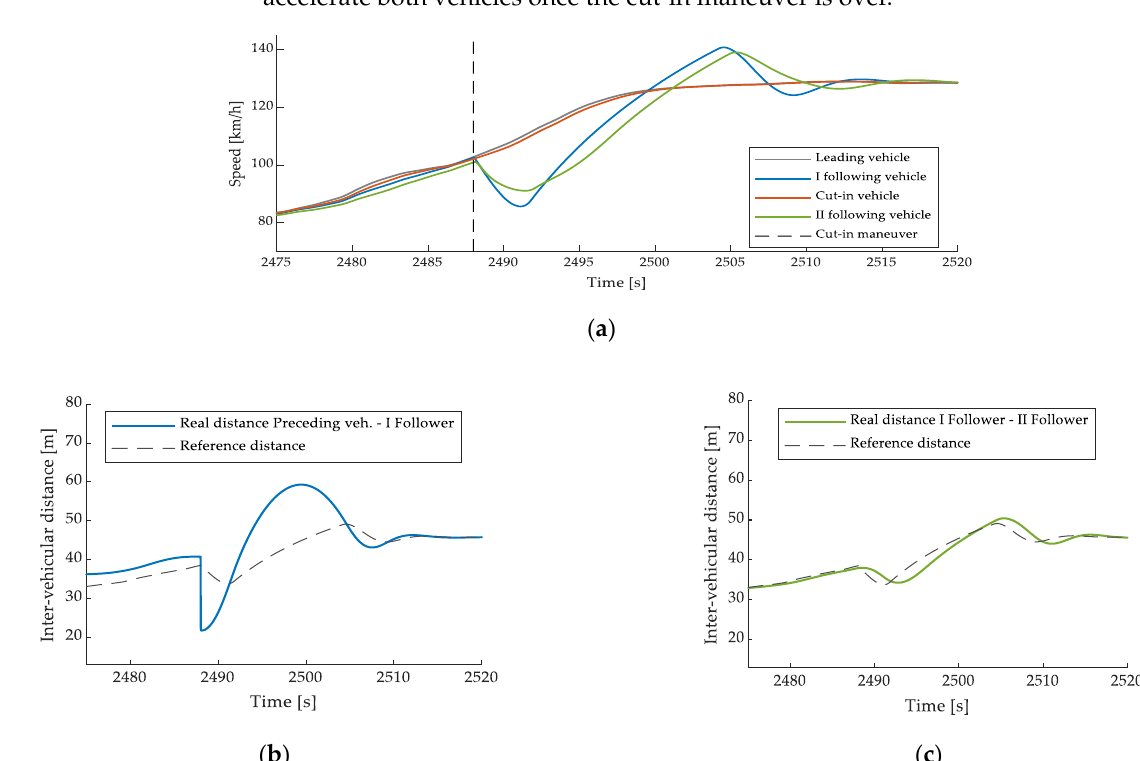
Figure 3. Safety analyses of the aggressive acceleration phase of the Random Cycle: ( a ) speed traces of the four vehicles (i.e., the three vehicles platooning and the fourth cutting in vehicle (in red)), ( b ) actual and reference inter-vehicular distances between the I follower and its preceding vehicle, and ( c ) actual and reference inter-vehicular distances between II and I followers.